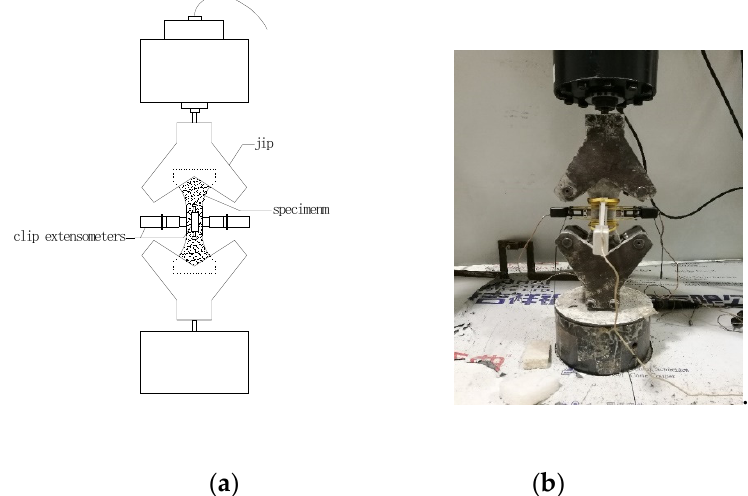
Figure 3. Four-point bending test: ( a ) Schematic representation (dimension in mm) and ( b ) Photo of test.